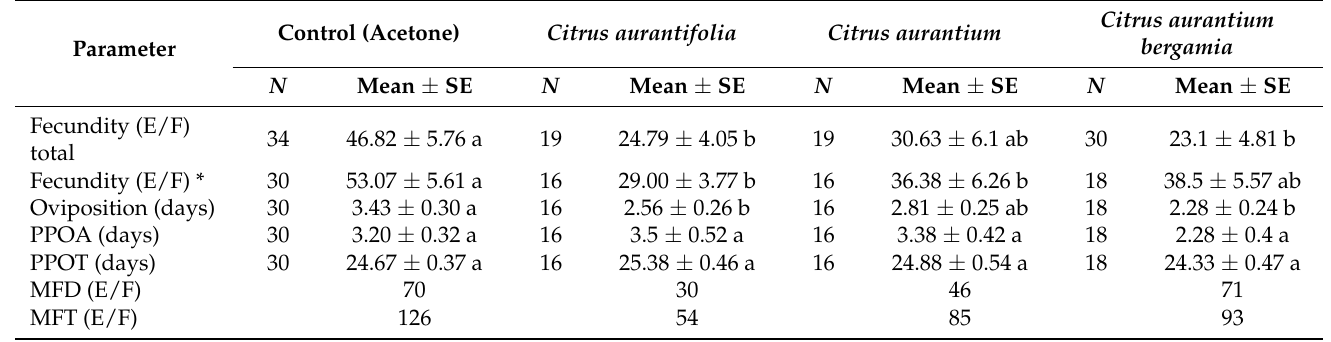
Figure 4. Age-stage-specific survival rate (Sxj) of Tuta absoluta treated with LC 50 Citrus aurantifolia , Citrus aurantium and Citrus aurantium bergamia EOs and only acetone (control). Table 3. Reproductive parameters of Tuta absoluta exposed to LC 50 Citrus aurantifolia, Citrus aurantium and Citrus aurantium bergamia EOs and only acetone (control).